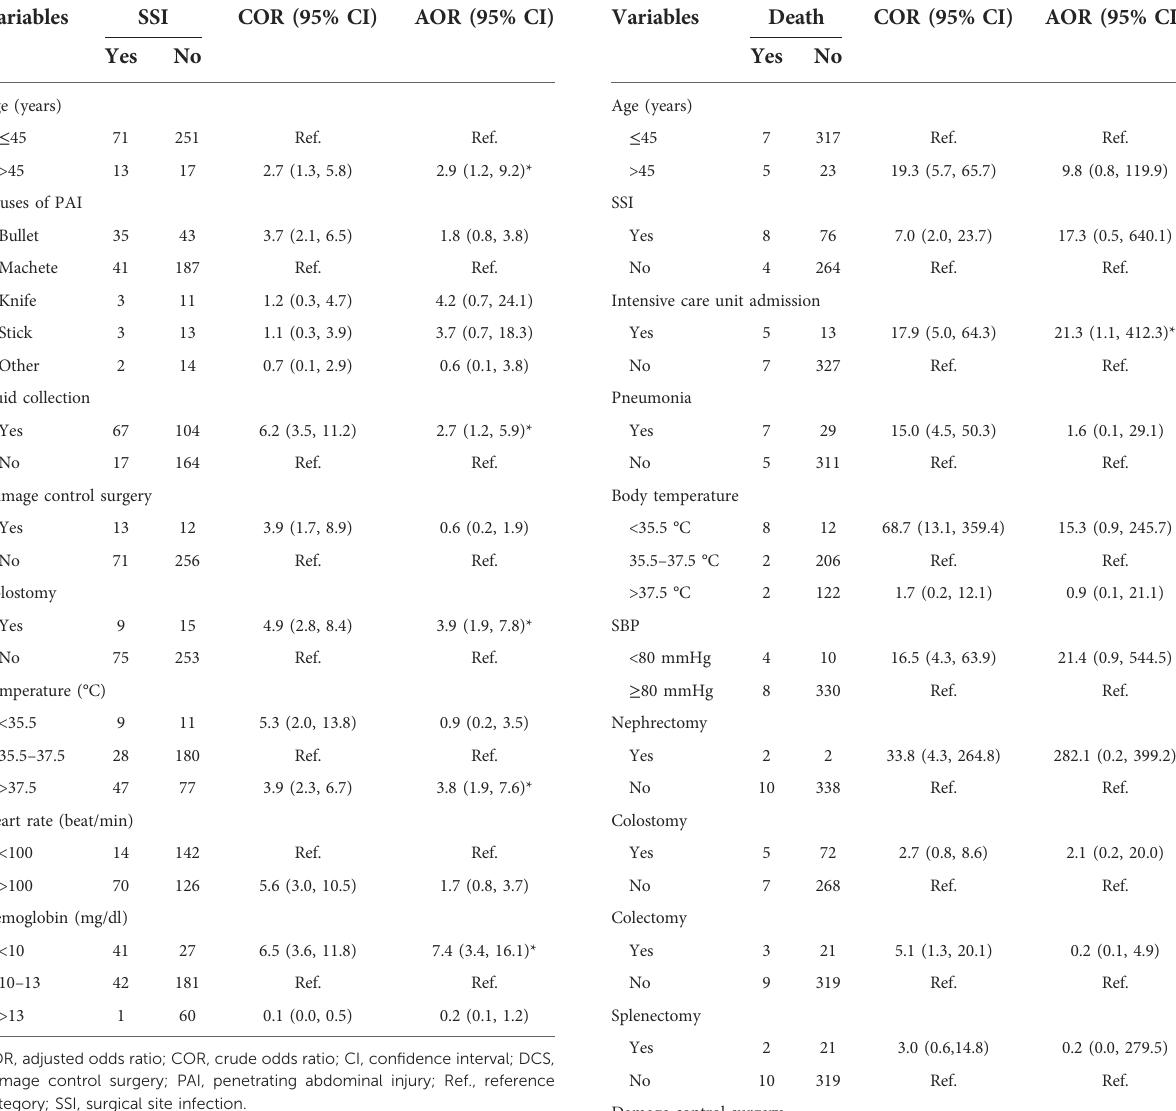
TABLE 3 Bivariable and multivariable binary logistic regression analyses for factors associated with SSI due to penetrating abdominal trauma during 2015 – 2019 at HFSUH, eastern Ethiopia.